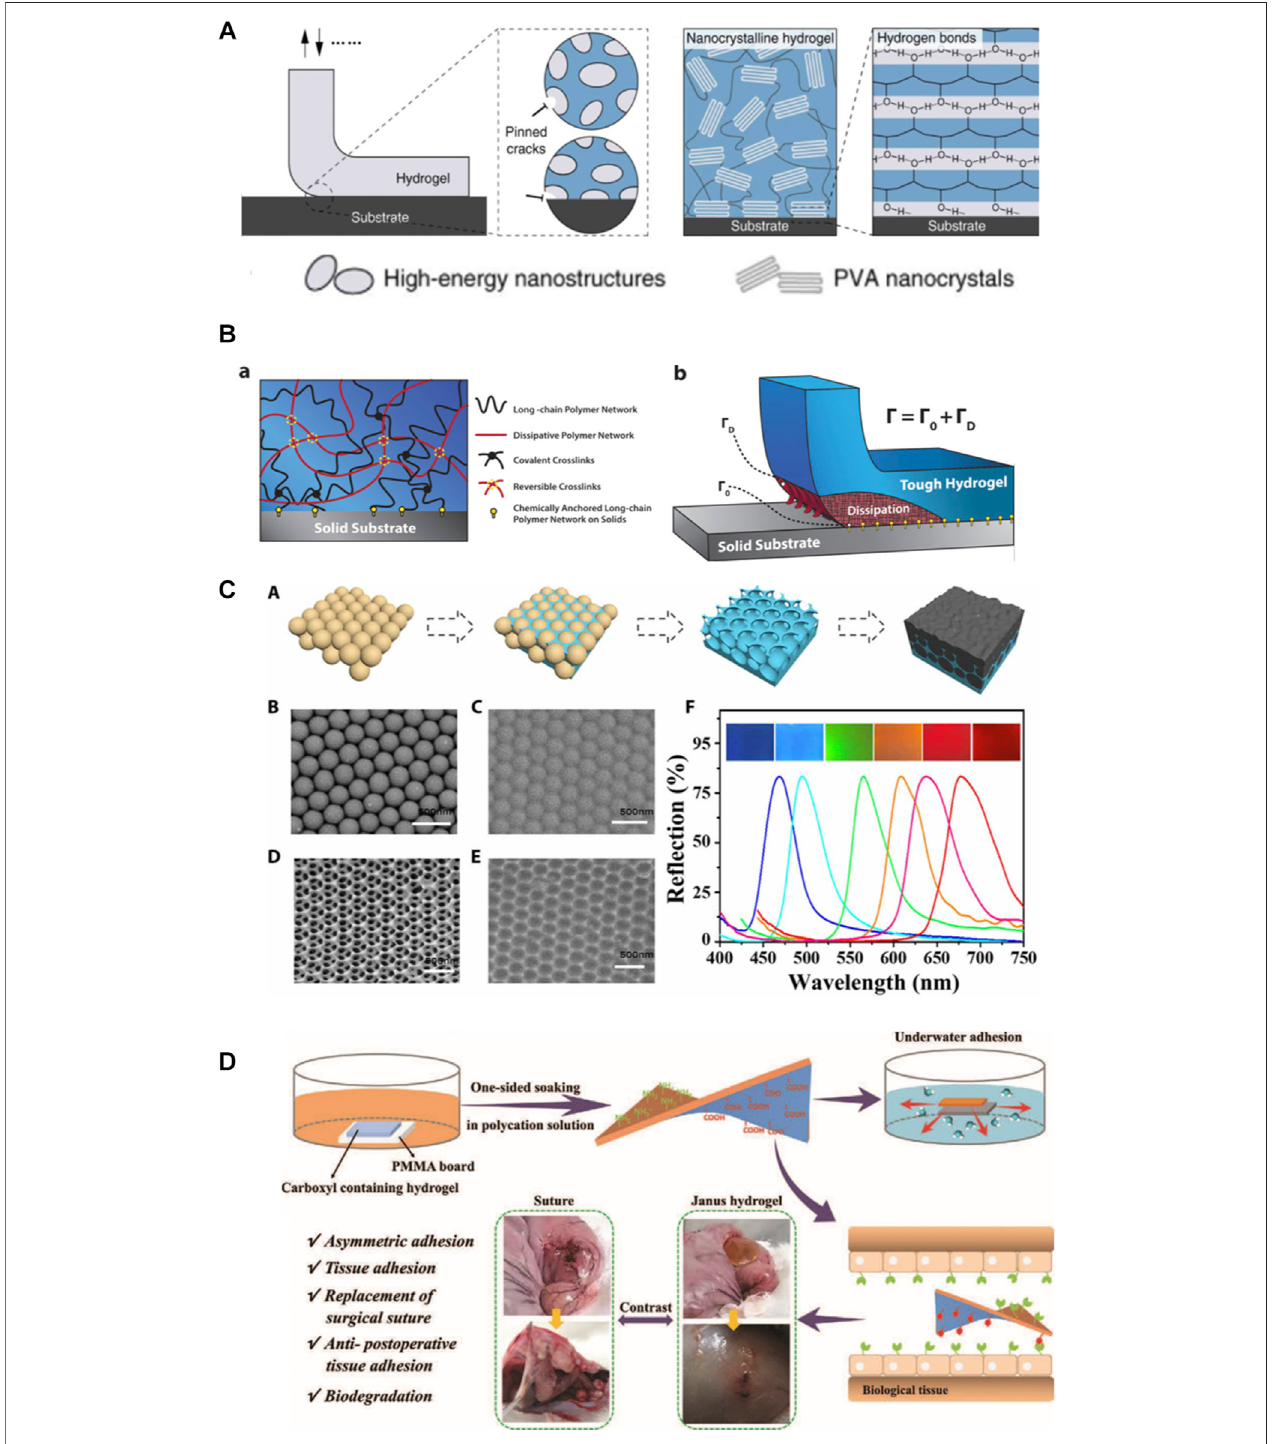
FIGURE4|(A) :high-energynanostructuresbioinspiredfatigue-resistantadhesion,fatigue-resistantadhesionofpoly(vinylalcohol)(PVA)hydrogel(Liuetal.,2020). (B) :designideaofhydrogeladhesiontodifferentmaterialsurface(Yuketal.,2016). (C) :theillustrationdepictstheformationofabioinspiredstructuralcolorpatch(Wang et al., 2020a). (D) : the illustration depicts the process of construction of a Janus hydrogel and repair of rabbit ’ s perforated stomach (Cui et al., 2020).